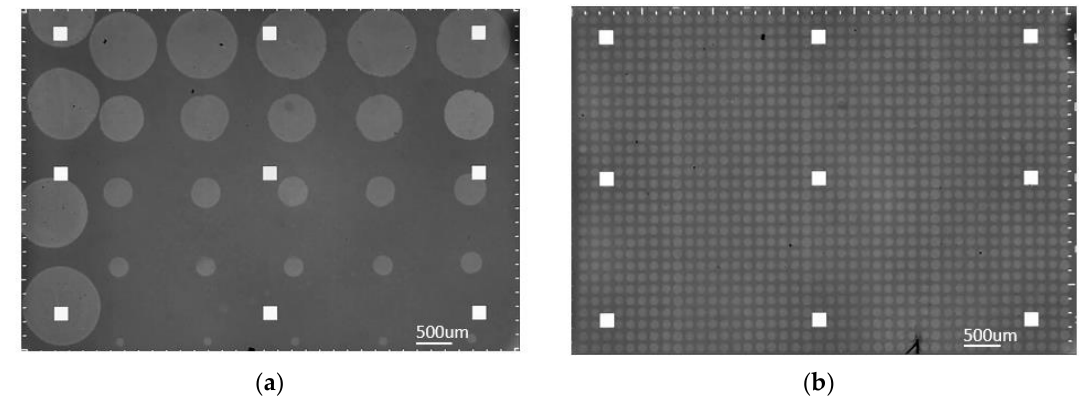
Figure 3. Spotted IRIS chips; ( a ) from left to right, one column of micropipette spots followed by five columns of robotically deposited spots in decreasing number of droplets per spot; ( b ) identical robotically dispensed single droplet spots (30 × 40 array).